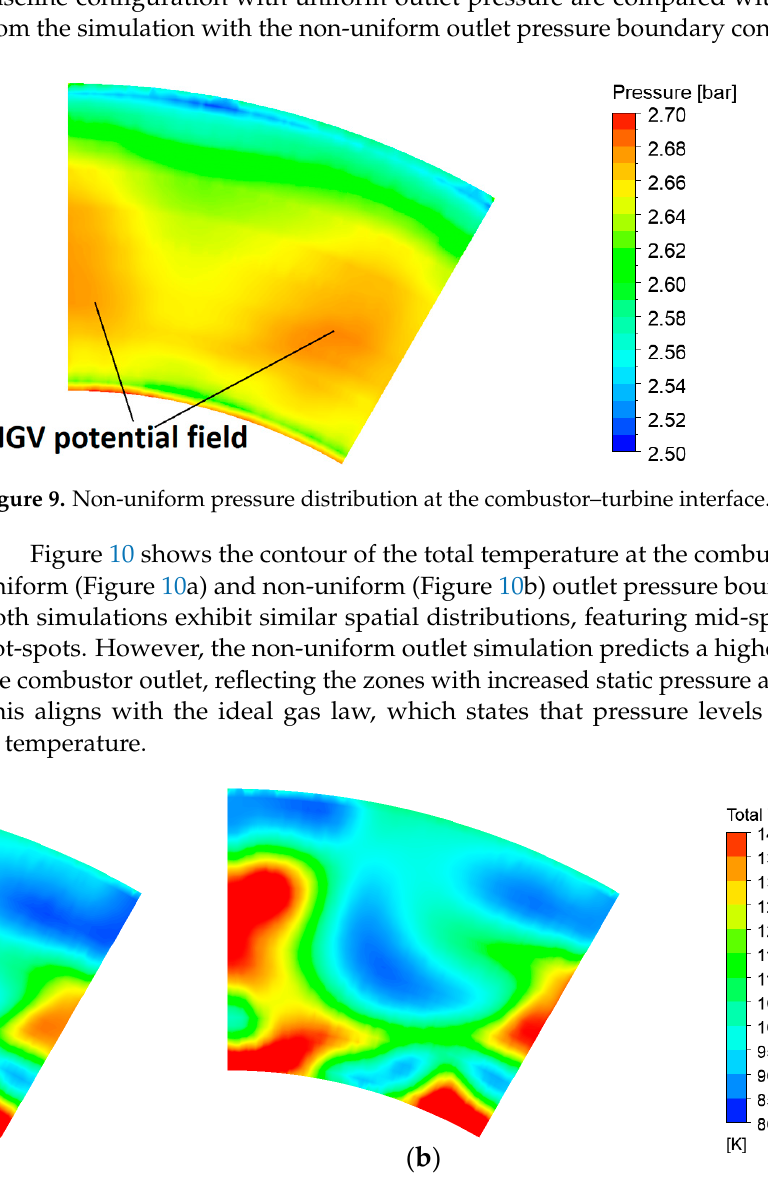
Figure 10. Combustor outlet total temperature contour with: ( a ) uniform outlet; ( b ) non-uniform outlet pressure boundary condition.